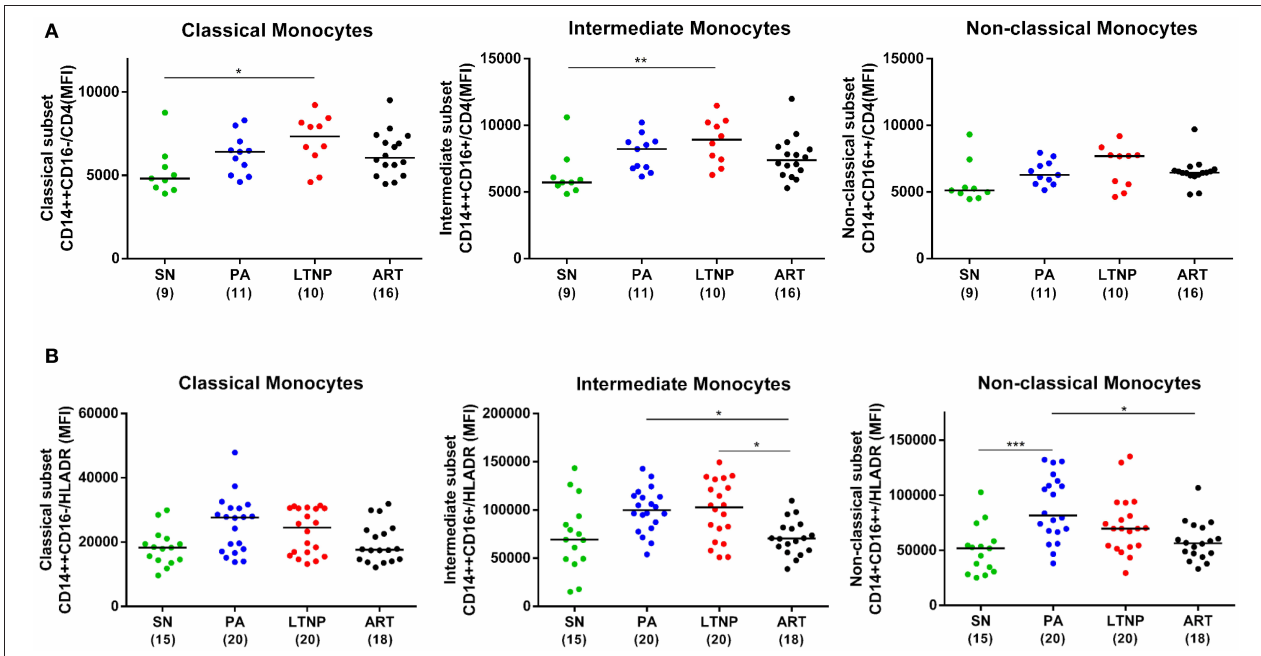
FIGURE 5 | Expression of CD4 and HLA-DR on monocyte subsets across cohorts. (A) Comparison of CD4 per-cell expression across PA, LTNP, ART and seronegative (SN) control groups in different monocyte subsets. Significance was ascertained using Kruskal-Wallis ANOVA followed by Dunn’s multiple comparison test; * P < 0.05; ** P < 0.01; *** P < 0.001. Elevated CD4 expression on intermediate monocytes was also observed to be significantly higher in PAs than SN individuals by unpaired t -test ( P < 0.05). (B) Comparison of per-cell expression of HLA-DR across cohorts in monocyte subsets. The plots reflect results of Kruskal-Wallis ANOVA followed by Dunn’s multiple comparison test. In addition, both ART-naïve groups showed significantly higher HLA-DR expression compared to seronegative controls across monocyte subsets based on pairwise comparisons by unpaired t -test (Classical—PA, P < 0.01; LTNP, P < 0.05; intermediate— P < 0.05 for both; non-classical—PA, P < 0.001; LTNP, P < 0.05).